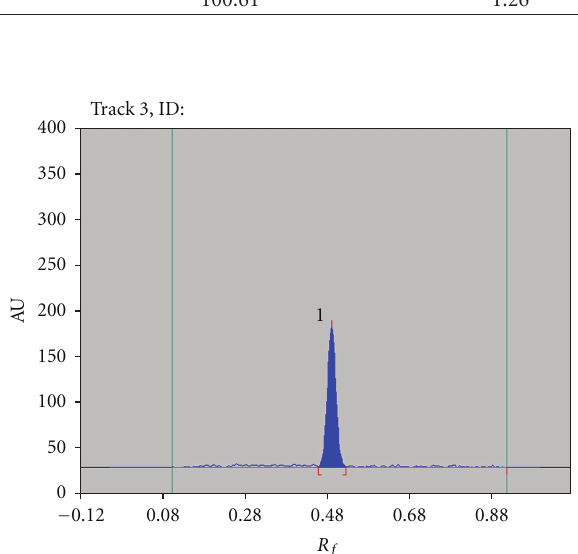
Figure 2: Densitogram of standard tenofovir disoproxil fumarate methanol (9.0:1.0 v/v).